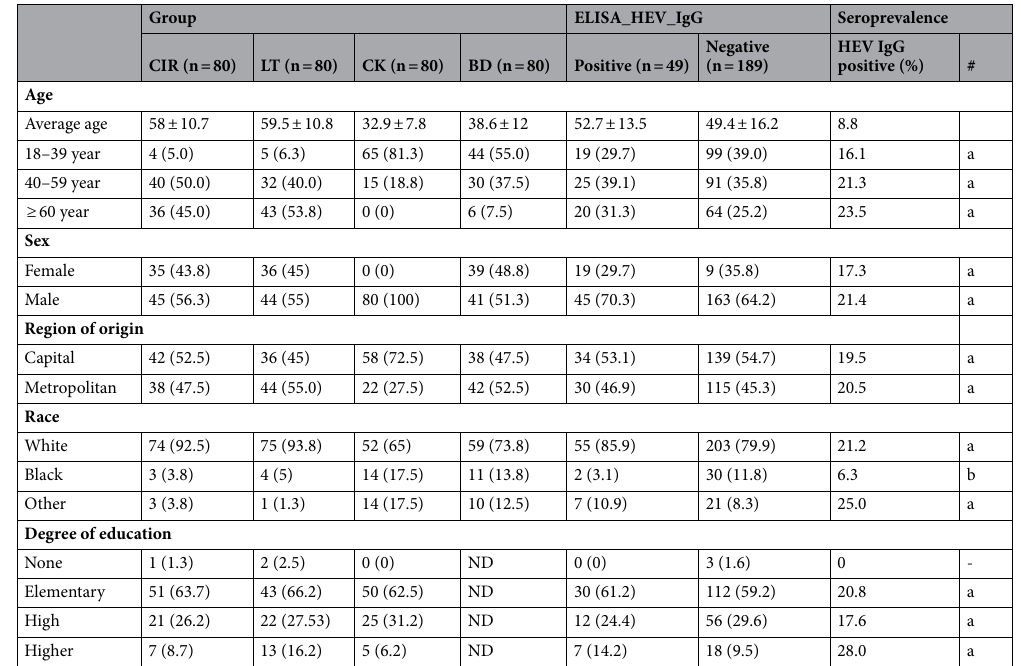
Table 1. Sociodemographic characteristics in different risk group for hepatitis E. CIR cirrhotic patients, LT liver transplant patients, CK crack users, LIA residents in a low income area, BD blood donors, ND not available. None: refer to individuals who did not complete primary school but are able to write and/or read. Summary by frequencies (%). Test for proportions difference, same letter across rows indicate not significant difference at